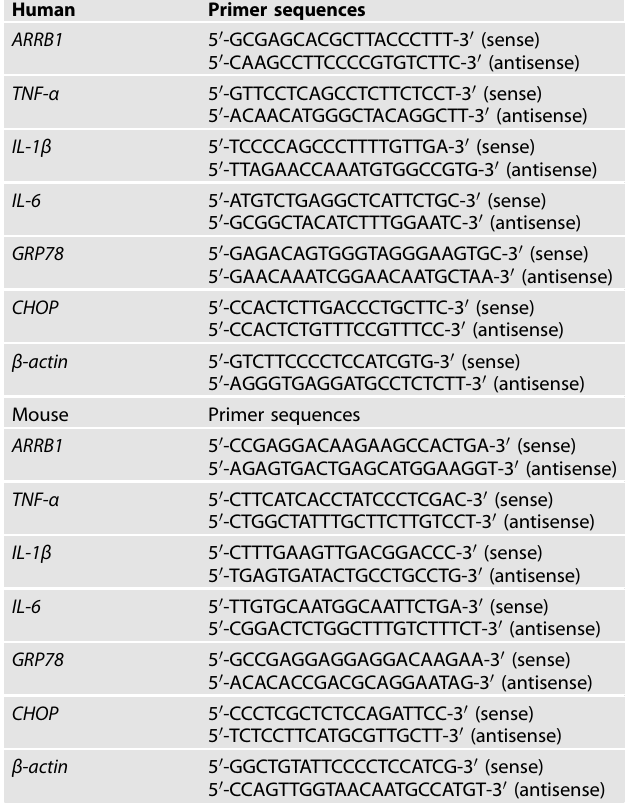
Table 1. Primer sequences used in real-time PCR analysis.